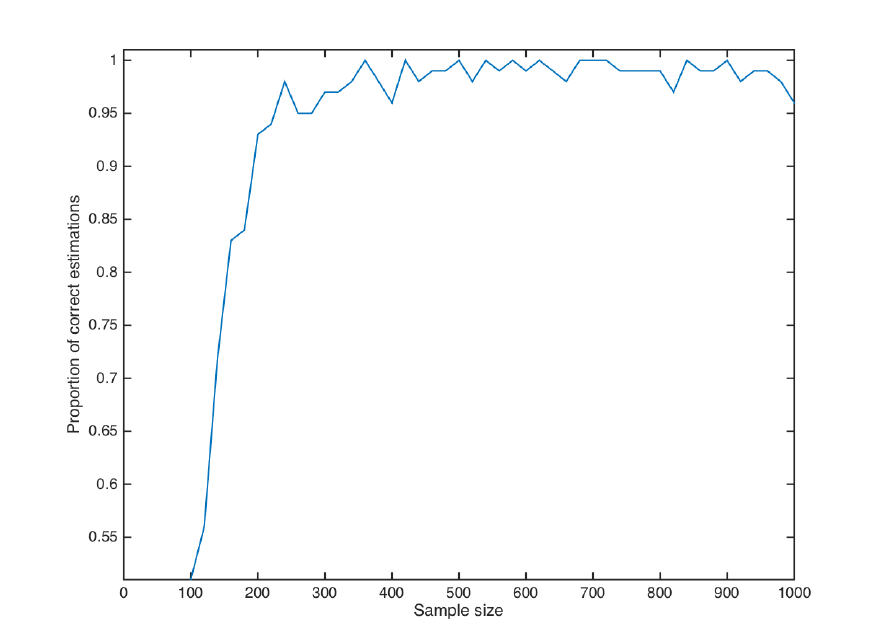
Figure 4. Proportion of correct identification of the context tree ¯ τ = { 2,01,11,21,20,10,00 } by applying Algorithm 1 to simulated data with sample sizes n = 100,120,140, . . . ,1000. For sample sizes larger than 200, the proportion of correct identification is at least